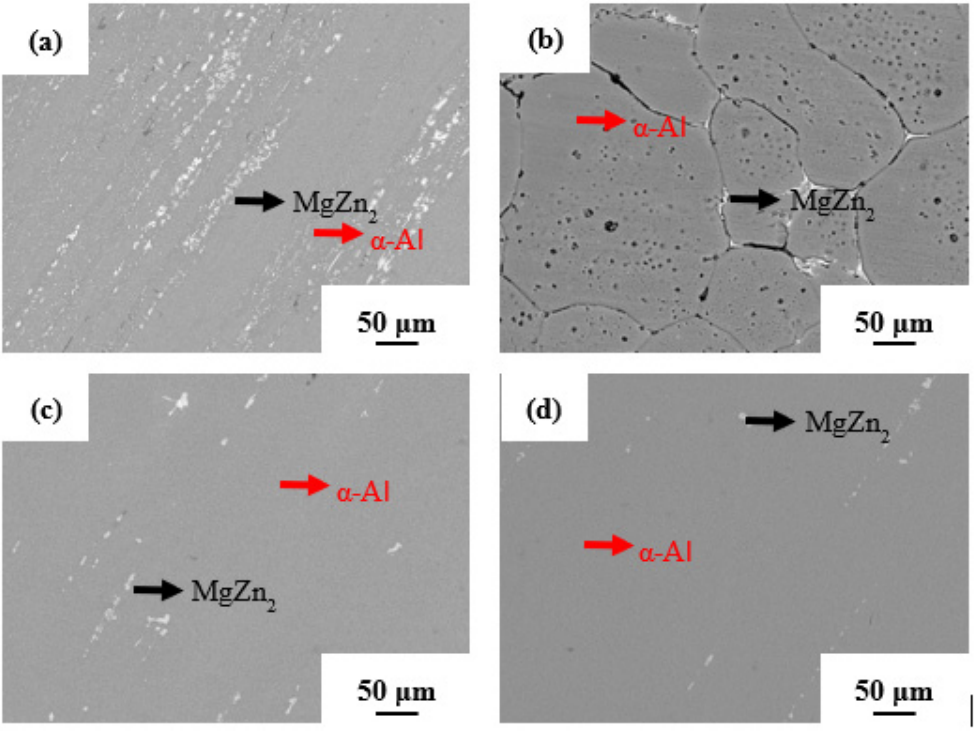
Figure 6. The scanning electron microscopy images of the ( a ) extruded Al-Zn-Mg-Cu-based alloy annealed under ( b ) atmospheric pressure, ( c ) 2 GPa, and ( d ) 3 GPa, respectively. Table 2. The Vickers hardness data observed for the Al-Zn-Mg-Cu-based samples.